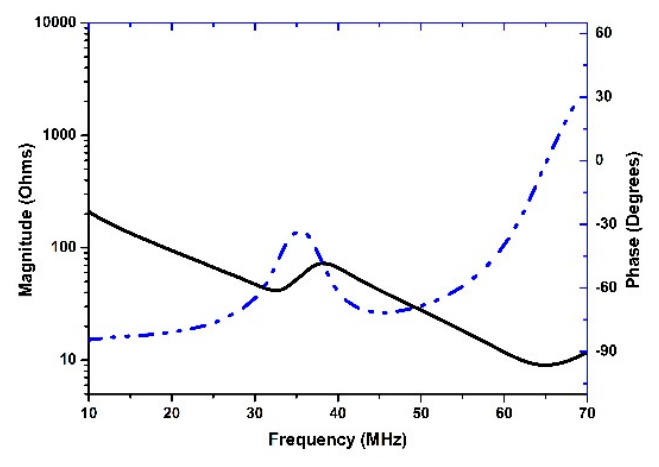
Figure 6. Measured electrical impedance magnitude (solid line) and phase angle (dash line) of BNT-BT tape-casting thick film.